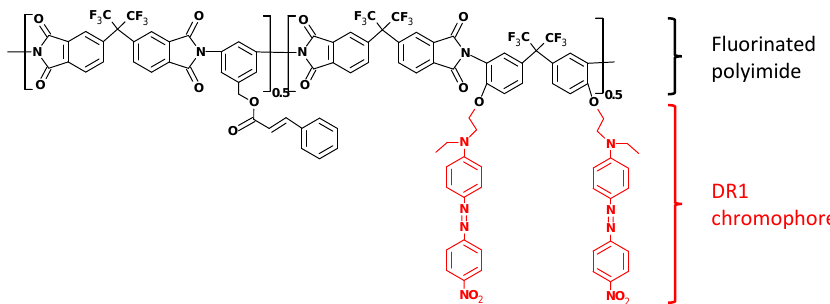
Figure 1. Scheme of the electro-optic (EO) polymer molecular structure used in this work, showing the fluorinated polyimide (black) and the DR1 chromophore side chain covalently bonded to the polyimide (red).